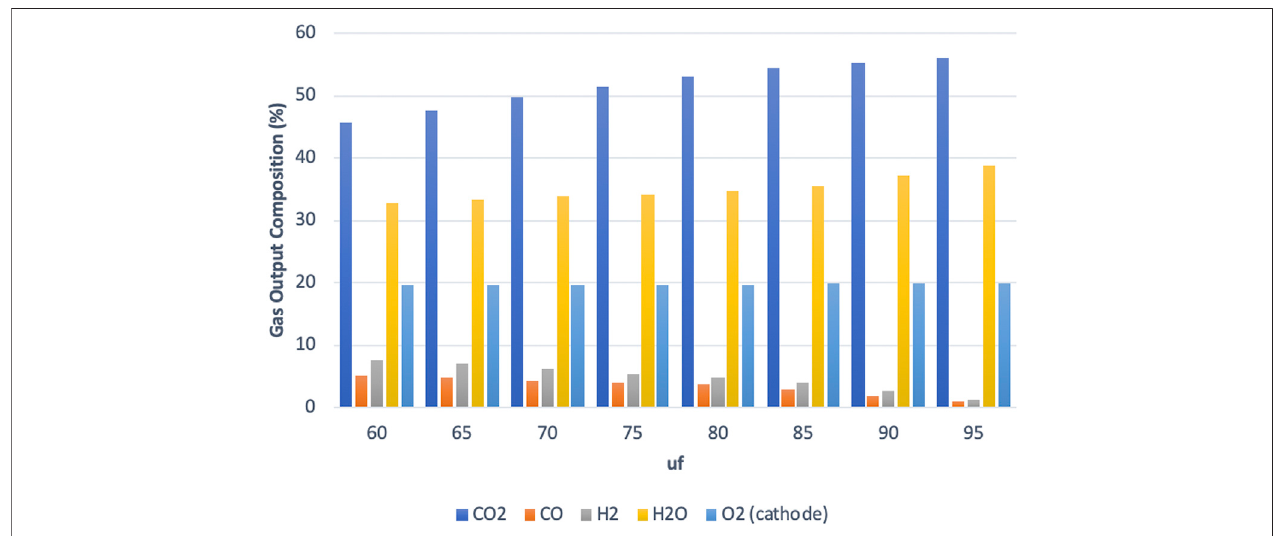
FIGURE 8 | Main gas output composition vs. utilization factor for high-power mode at the MCFC output.